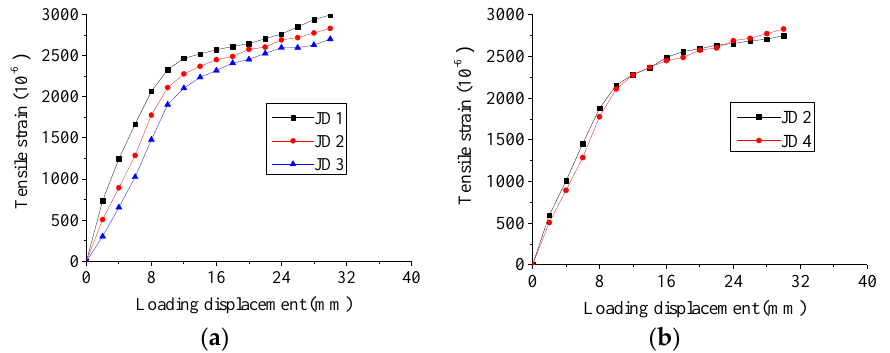
Figure 9. Loading displacement–steel bar strain curve of B–R1. ( a ) Thickness of rubber sleeve. ( b ) Thickness of rubber pad.